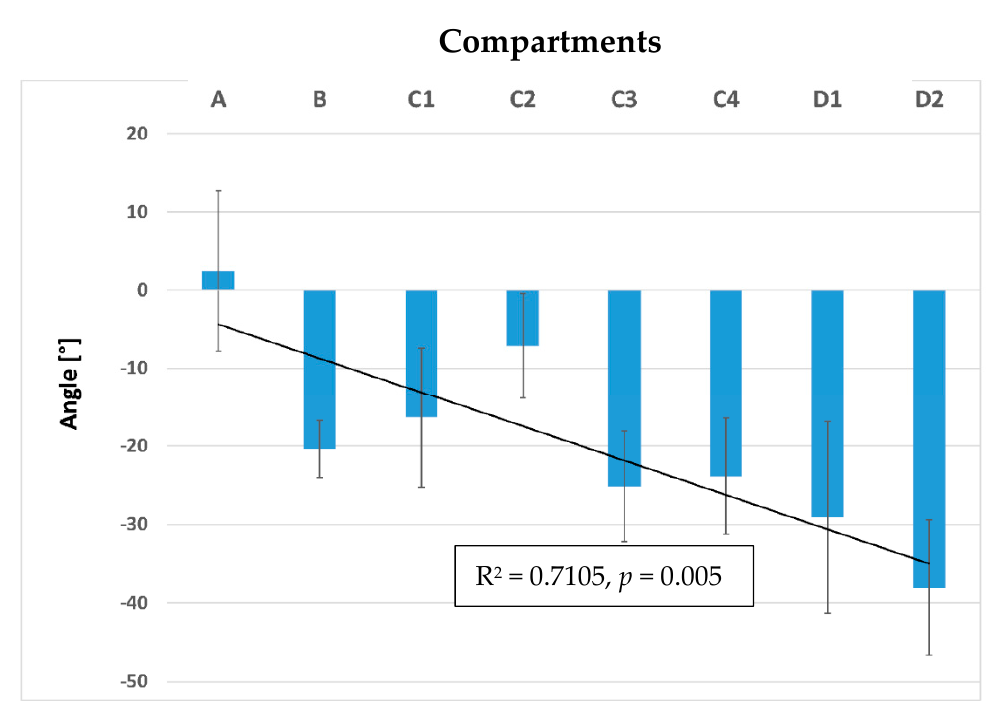
Figure 8. Mean pennation angles of the longissimus dorsi muscle to the horizontal plane calculated for each compartment A – D and sub-compartments C1 – C4 and D1 and D2 . Compared to cranial compartment A , the pennation angles to the horizontal plane change the orientation and get steeper in the caudal direction (see significant linear regression, R 2 = 0.71, p = 0.005), with the lowest values found in compartment D .